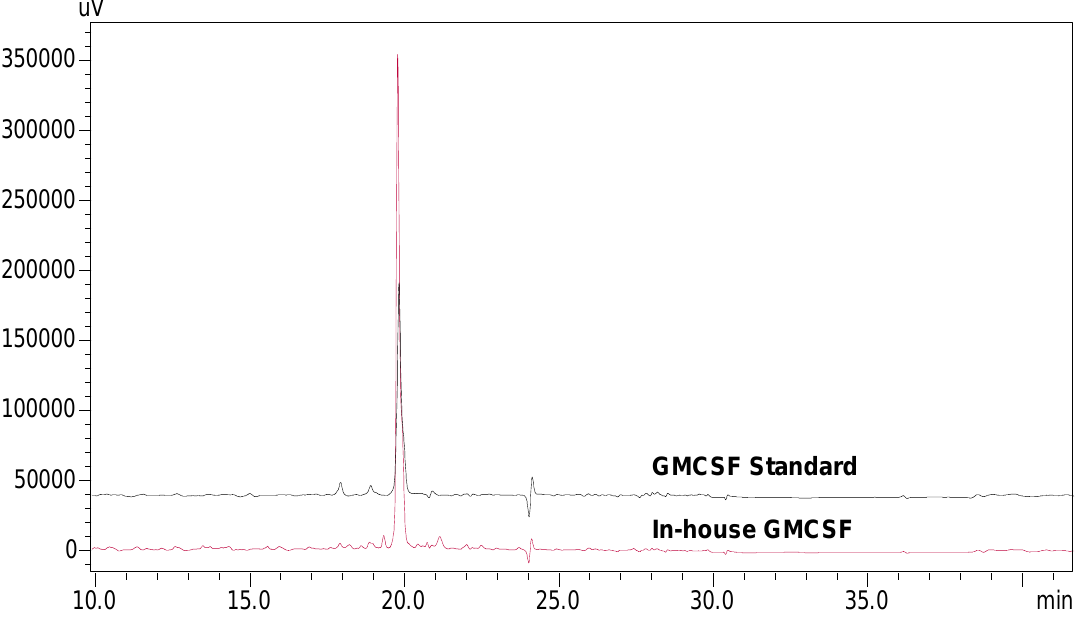
Figure 4. Reverse phase chromatograph showing comparison of standard GMCSF and in-house purified hGMCSF with optimum mobile phase consisting of 0.1% TFA in 10% acetonitrile ( a ) and 0.1% TFA in 90% acetonitrile ( b ). Flow rate was maintained at 1 mL/min and detection was at 215 nm. Black line represents standard hGMCSF while red line indicates the in-house purified rhGMCSF.